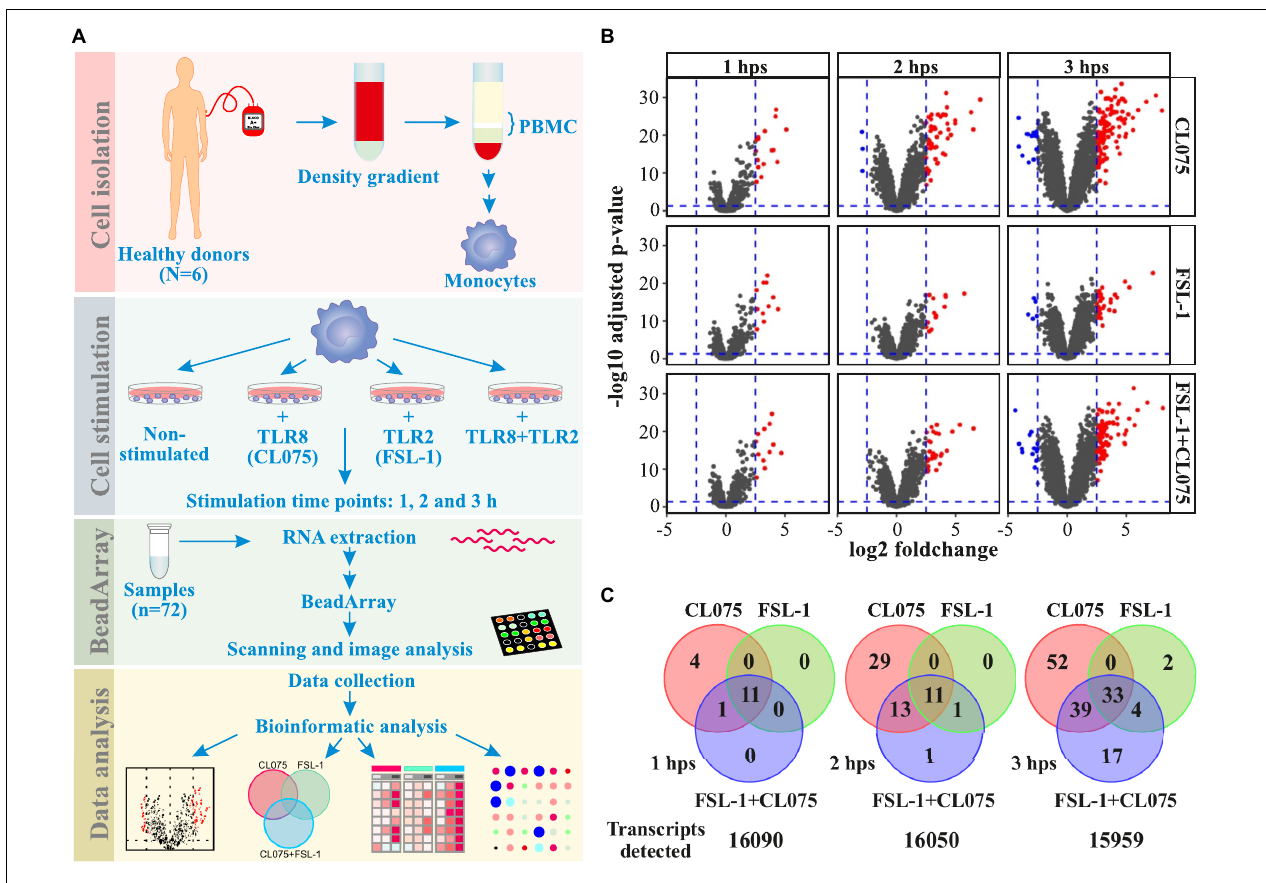
FIGURE 1 | Distribution of differentially regulated genes after TLR8, TLR2 or co-stimulation in monocytes. (A) Human primary monocytes ( n = 6) were stimulated with a TLR8 ligand (CL075, 1 µ g/mL), a TLR2 ligand (FSL1, 100 ng/ml) or both and cells were lysed and RNA extracted after 1, 2, and 3 h. (B) Transcriptome analysis was performed using Illumina HT-12 v4 bead array. Corresponding volcano plots shows that TLR8 stimulation gives a larger magnitude of differentially expressed genes than TLR2 stimulation alone or co-stimulation compared to non-stimulated samples at the same time-point. (C) A common core set of inflammatory genes are induced, but TLR8 stimulation induce more unique genes at later time points than TLR2 stimulation. Co-stimulation induces more genes than TLR2 but less than TLR8 alone, with a significant subset shared only with TLR8